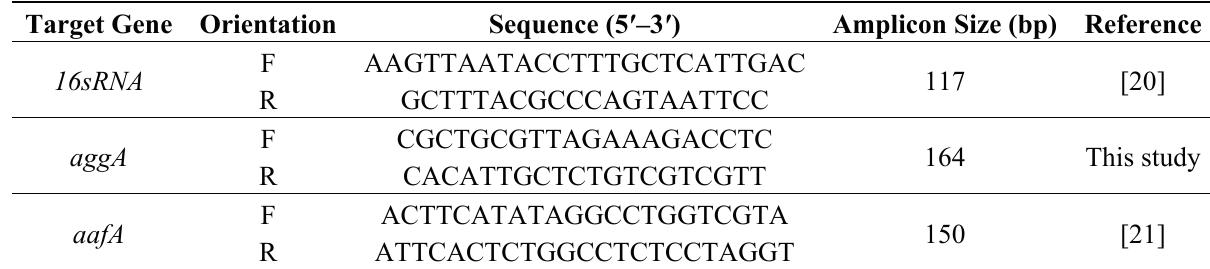
Table 1. List of primers used in the